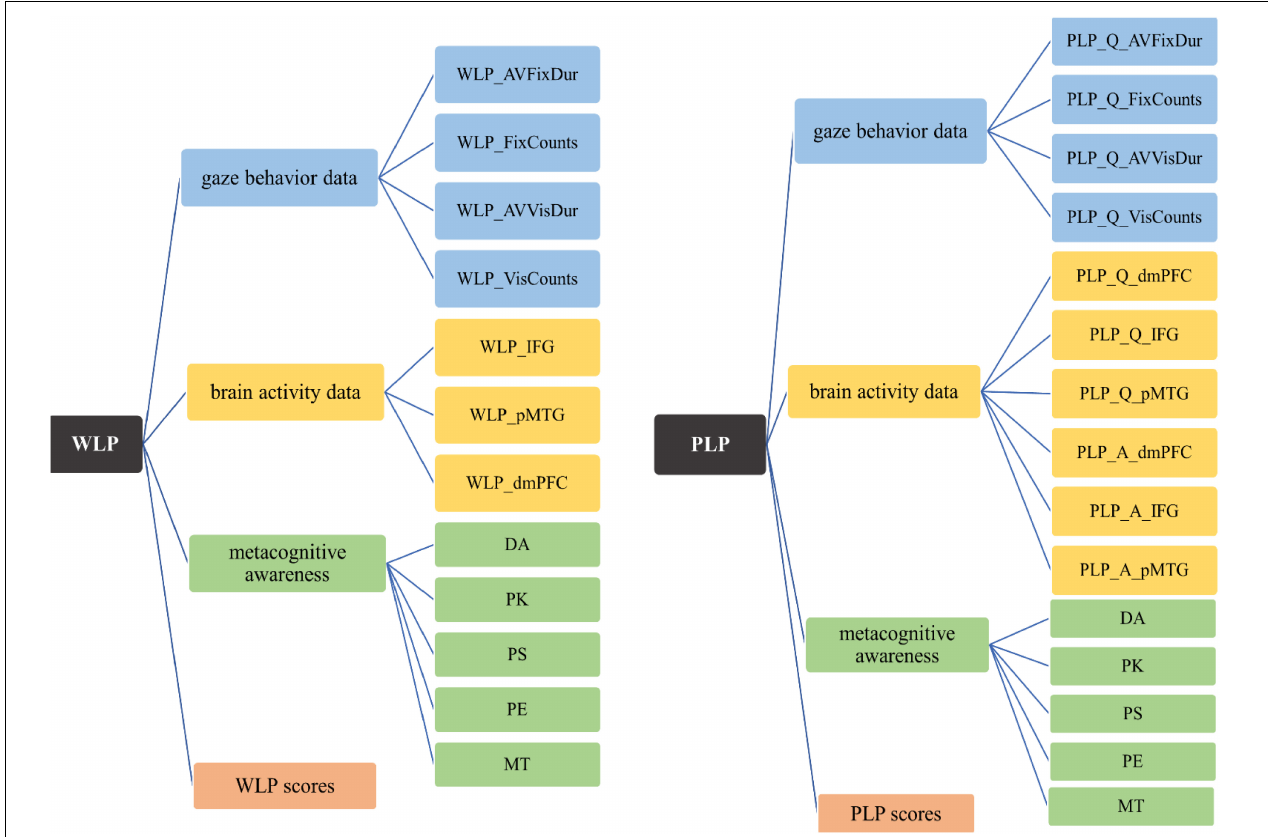
FIGURE 2 | The variables used in the current study. A, the audio texts listening phase; AVFixDur, average fixation duration; AVVisDur, average visit duration; DA, directed attention; dmPFC, dorsomedial prefrontal cortex; FixCounts, fixation counts; IFG, inferior frontal gyrus; MT, mental translation; PE, planning and evaluation; PK, person knowledge; PLP, post-listening performance; pMTG, posterior middle temporal gyrus; PS, problem solving; Q, the answering phase; VisCounts, visit counts; WLP, while-listening